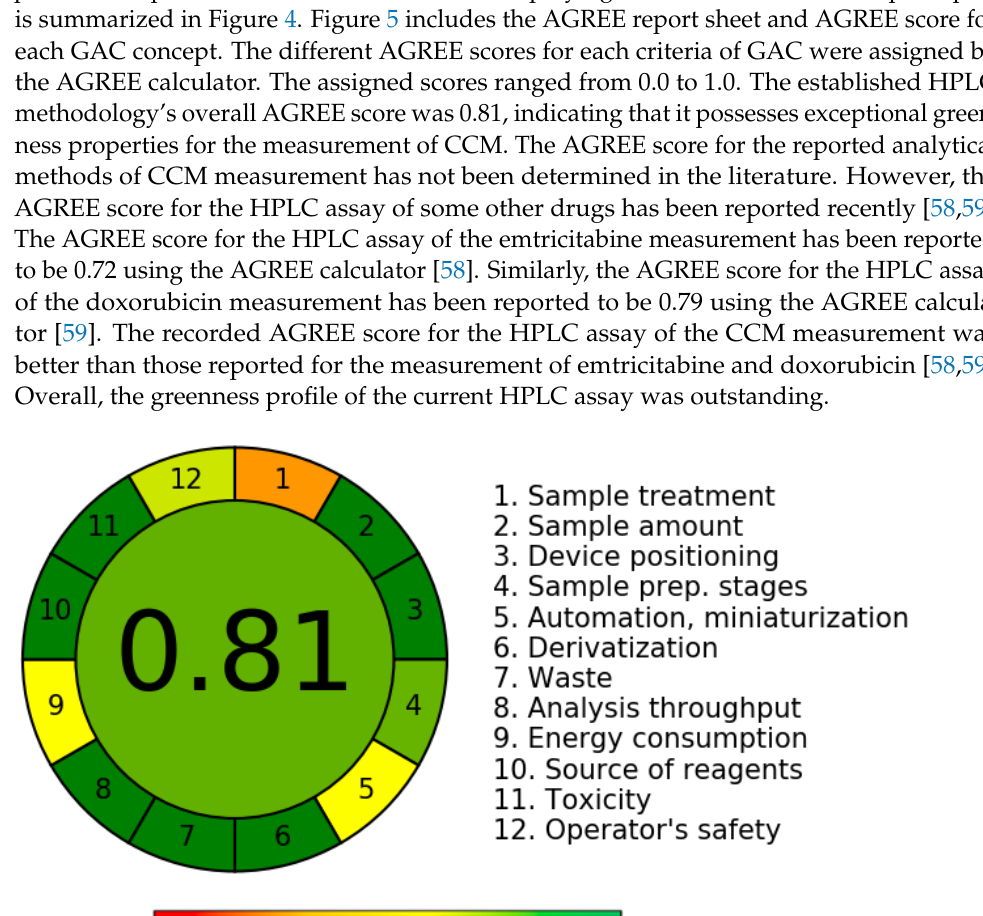
Figure 5. AGREE scale sheet presenting AGREE scale for 12 distinct components of GAC for the established HPLC methodology of CCM determination recorded using AGREE calculator.